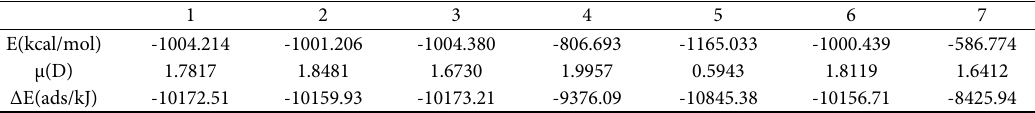
Table 4. Table 4. Energy of Triclosan-C60 complexes in different active